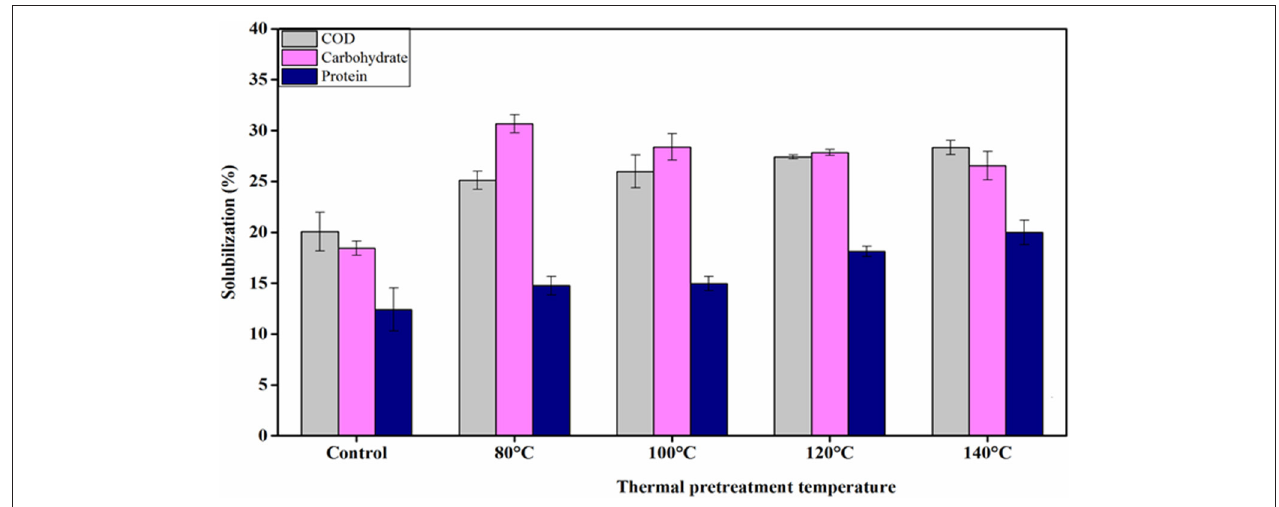
FIGURE 2 | Solubilization of COD, carbohydrate and protein of FW before and after each TP.